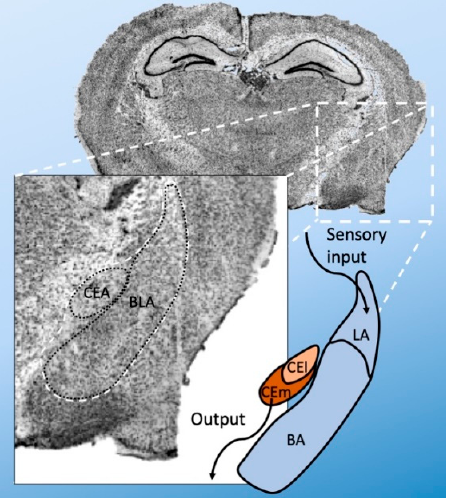
Figure 1. Anatomical subdivision of the amygdala (i.e., of the mouse). The amygdala is mainly subdivided into basolateral amygdala (BLA) and central nuclei (CEA). The BLA is further divided into basolateral (BA) and lateral amygdala (LA). The CEA is subdivided into a lateral (CEl) and medial (CEm) part. Broadly, the LA is the point of sensory input, and CEm is the main point of output to the brain